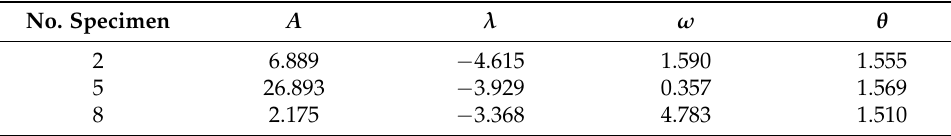
Table 4. Key parameter values of residual stress fitting